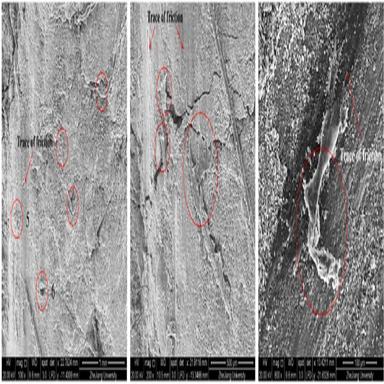
SEM images of fatigue failure surface indicating the trace of friction of fibre during the fatigue loading, adapted from .